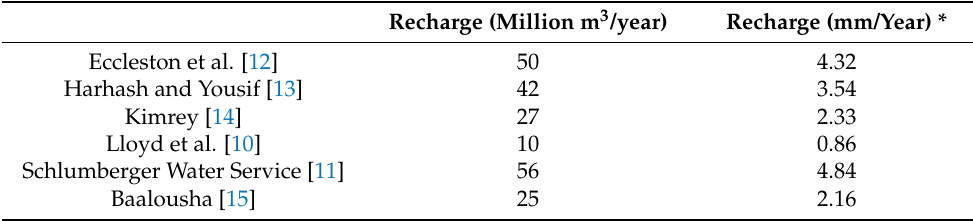
Table 1. Groundwater recharge estimates (* averaged over the whole Qatar surface